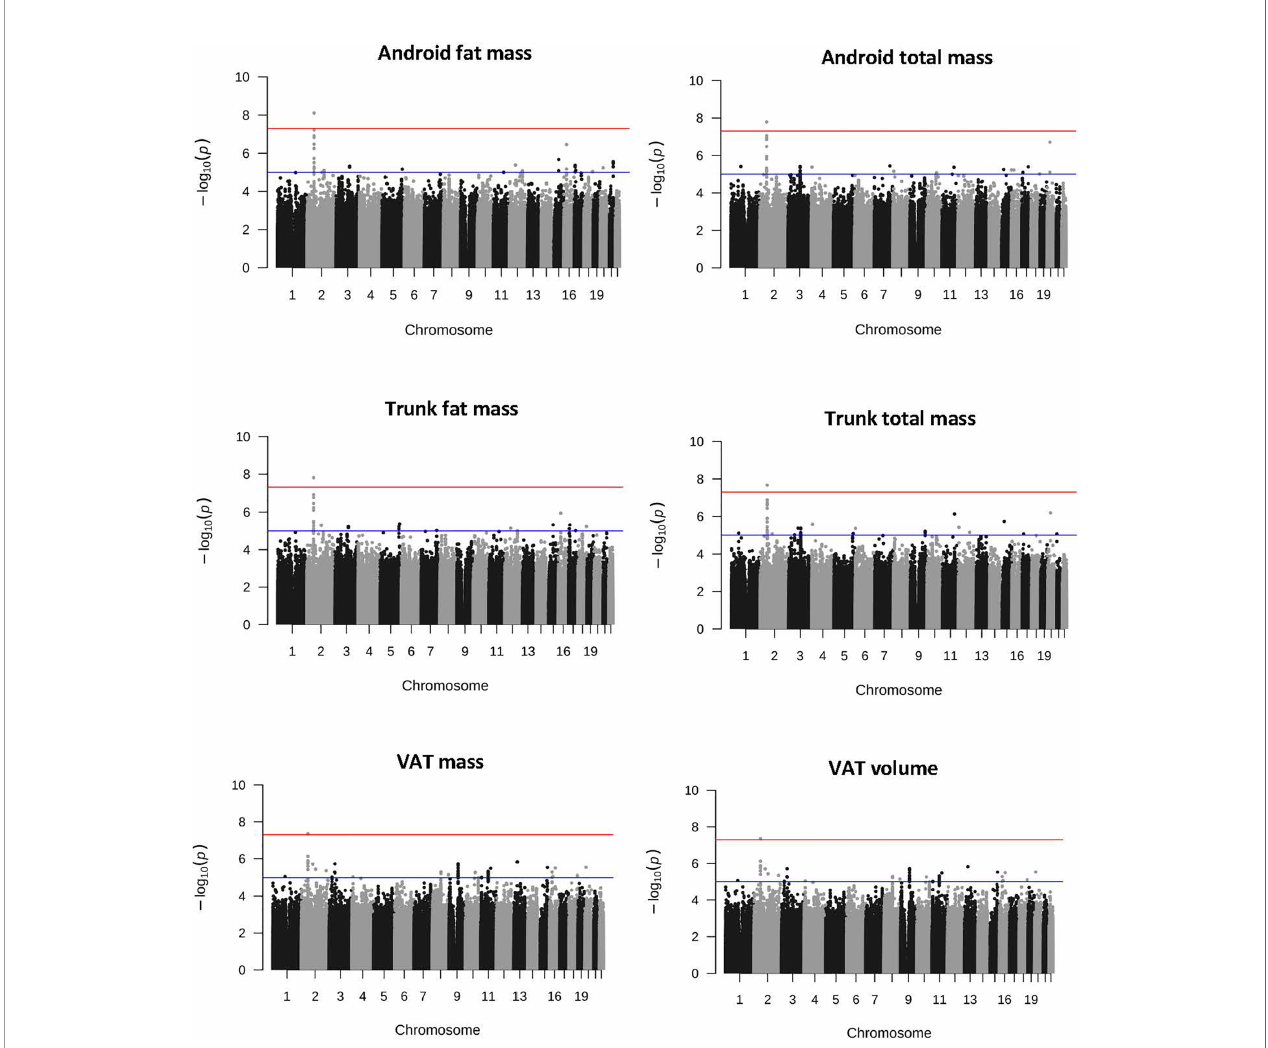
FIGURE 1 | Manhattan plot of obesity-related SNP rs7592270 statistically signi fi cant above line at p-value 5.0 x 10 -8 in the combined (male and female) GWAS (n = 4 386; VAT, n = 4 336) VAT, visceral adipose